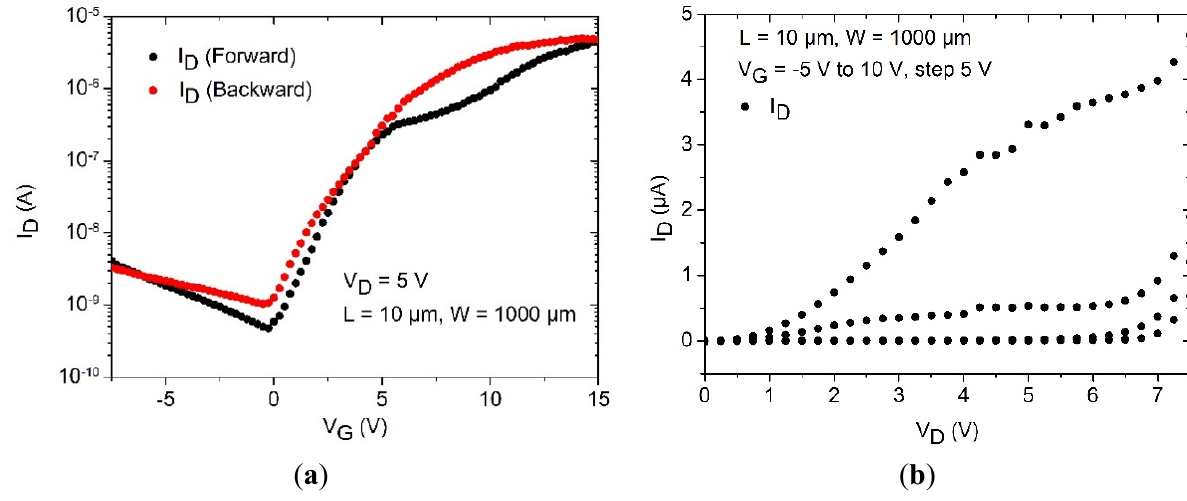
Figure 18. ( a ) Transfer and ( b ) output characteristics of an inverted coplanar ZnO nanoparticle TFT using spray coating technique and a high- k dielectric (L = 10 µm, W = 1000 µm and t ins = 200